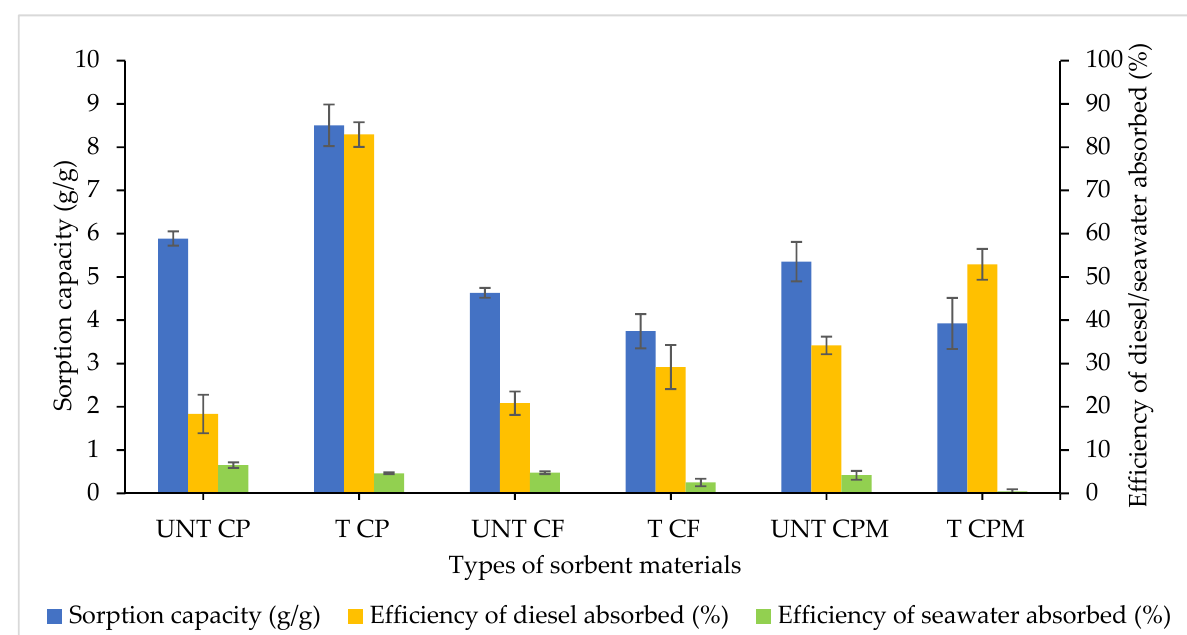
Figure 1. Screening for CP sorbent materials. UNT: untreated, T: treated, CP: coco peat, CF: coco fibre and CPM: coco peat mix (1 peat: 1 fibre). The error bars represent the mean ± SEM for three replicates ( n = 3).